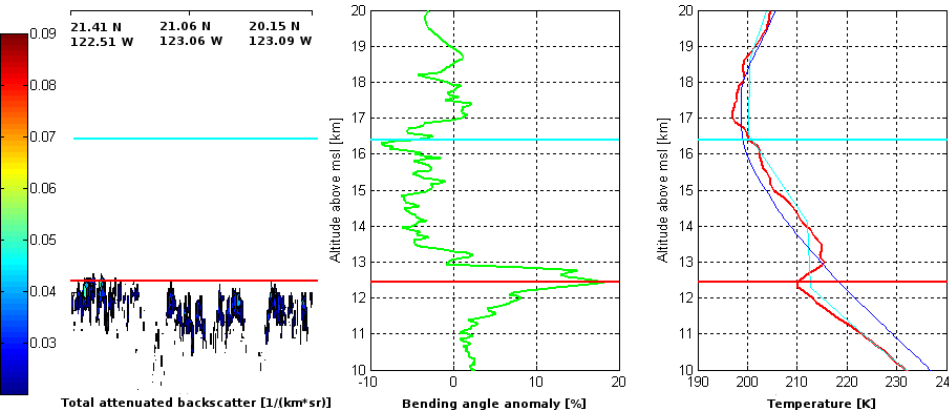
Fig. 3. Vertical profile associated with the convective system identified in Fig. 2 (2 February 2008). The left panel shows the total attenuated backscatter at 532nm from CALIOP (10:08:00UTC), along the orbit track shown in Fig. 2. The right panels show the bending angle anomaly profile (green) and the temperature profile (red) from GPS RO (09:53:00UTC) during the storm. The temperature plot also shows the profile from the ECMWF analysis (cyan) and the climatological temperature profile (blue). The horizontal cyan line is the altitude of the standard tropopause and the horizontal red line is the altitude of the coldest point and the bending angle anomaly spike.